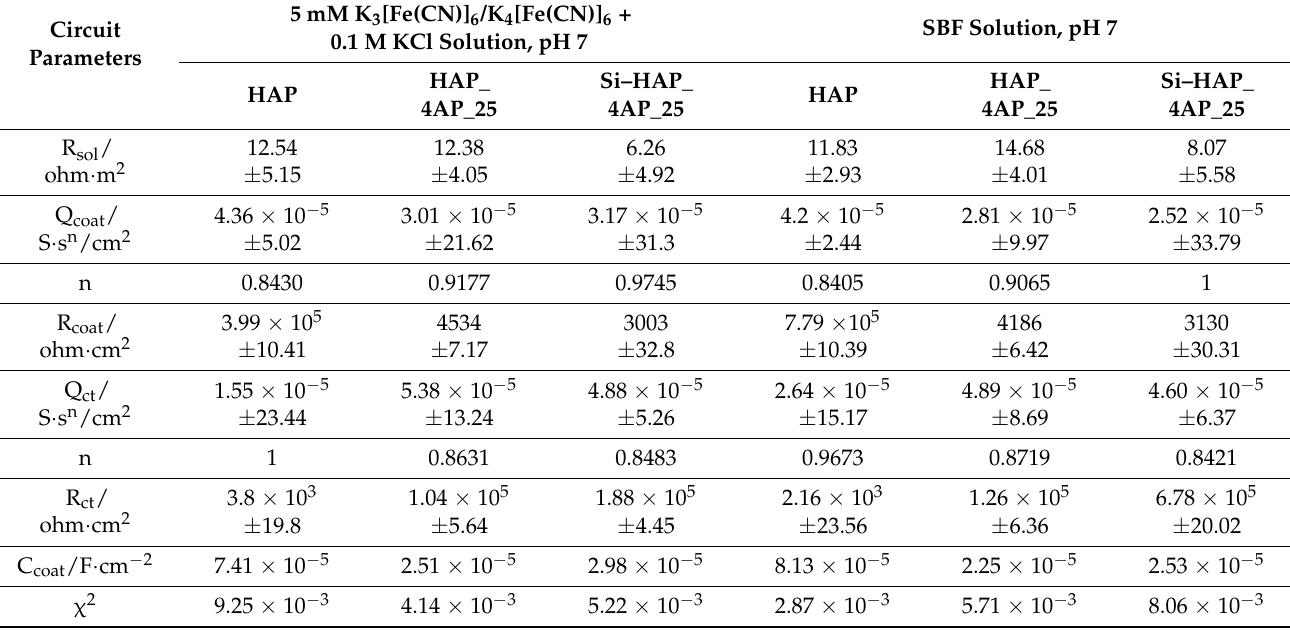
Table 2. EIS parameters of HAP-Chit/Ti, HAP_4AP_25-Chit/Ti, and Si–HAP_4AP_25-Chit/Ti